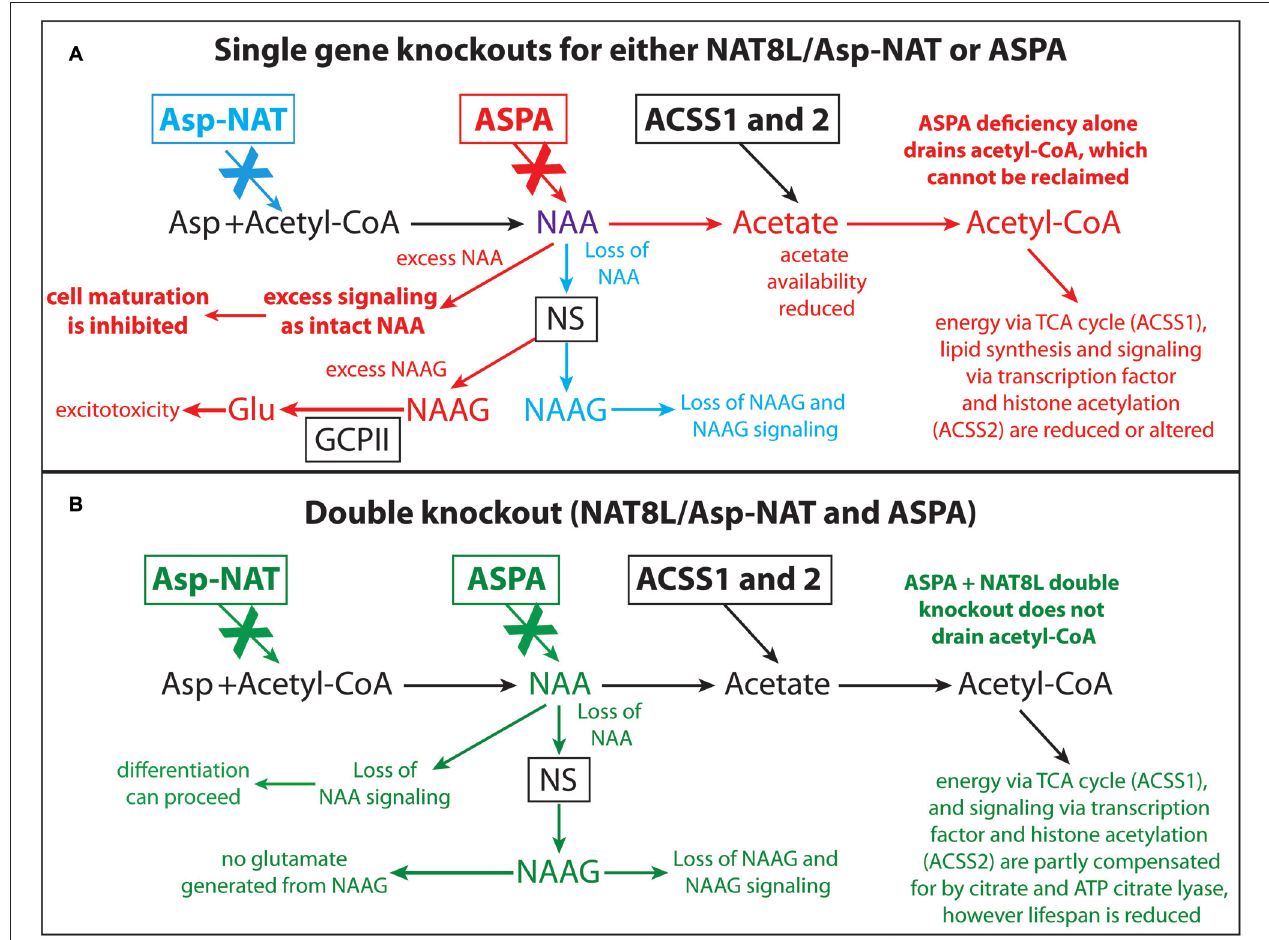
FIGURE 10 | Schematic depicting the effects of Nat8L and Aspa gene knockouts and associated pathophysiological changes. Single gene deletion effects for Nat8L /Asp-NAT (blue) and Aspa (red) are shown in (A) , whereas changes associated with the double knockout mice (green) are shown in (B) . Only the effects associated with the single Aspa gene knockout (red) result in brain vacuolization. Two major differences between the single ASPA knockout mice and the dual Nat8L + Aspa knockout are that in the double knockout mice acetyl-CoA is not depleted and trapped as NAA, and excess NAA signaling or other potentially toxic actions from NAA are not possible. Further, no NAAG signaling occurs in the dual knockout mice, whereas excess NAAG is present in the single Aspa deficient mice. Acss1 and Acss2 convert acetate, including acetate derived from Aspa-mediated deacetylation of NAA, into acetyl-CoA for energy derivation, lipid synthesis and protein acetylation reactions. In Aspa deficiency alone, acetyl-CoA is removed from the system, and cannot be reclaimed. This affects downstream utilization of acetate by Acss1 and Acss2. Acetyl-CoA is not depleted in the Nat8L + Aspa double knockout mice because no acetyl-CoA is used to synthesize NAA. Abbreviations: Asp, aspartate; Asp-NAT, aspartate N-acetyltransferase (Nat8L); ASPA, aspartoacylase; Acss1 and 2, acyl-CoA short chain synthetase 1 and 2; Glu, glutamate; GCPII, glutamate carboxypeptidase-2; NAAG, N-acetylaspartylglutamate; NS, NAAG